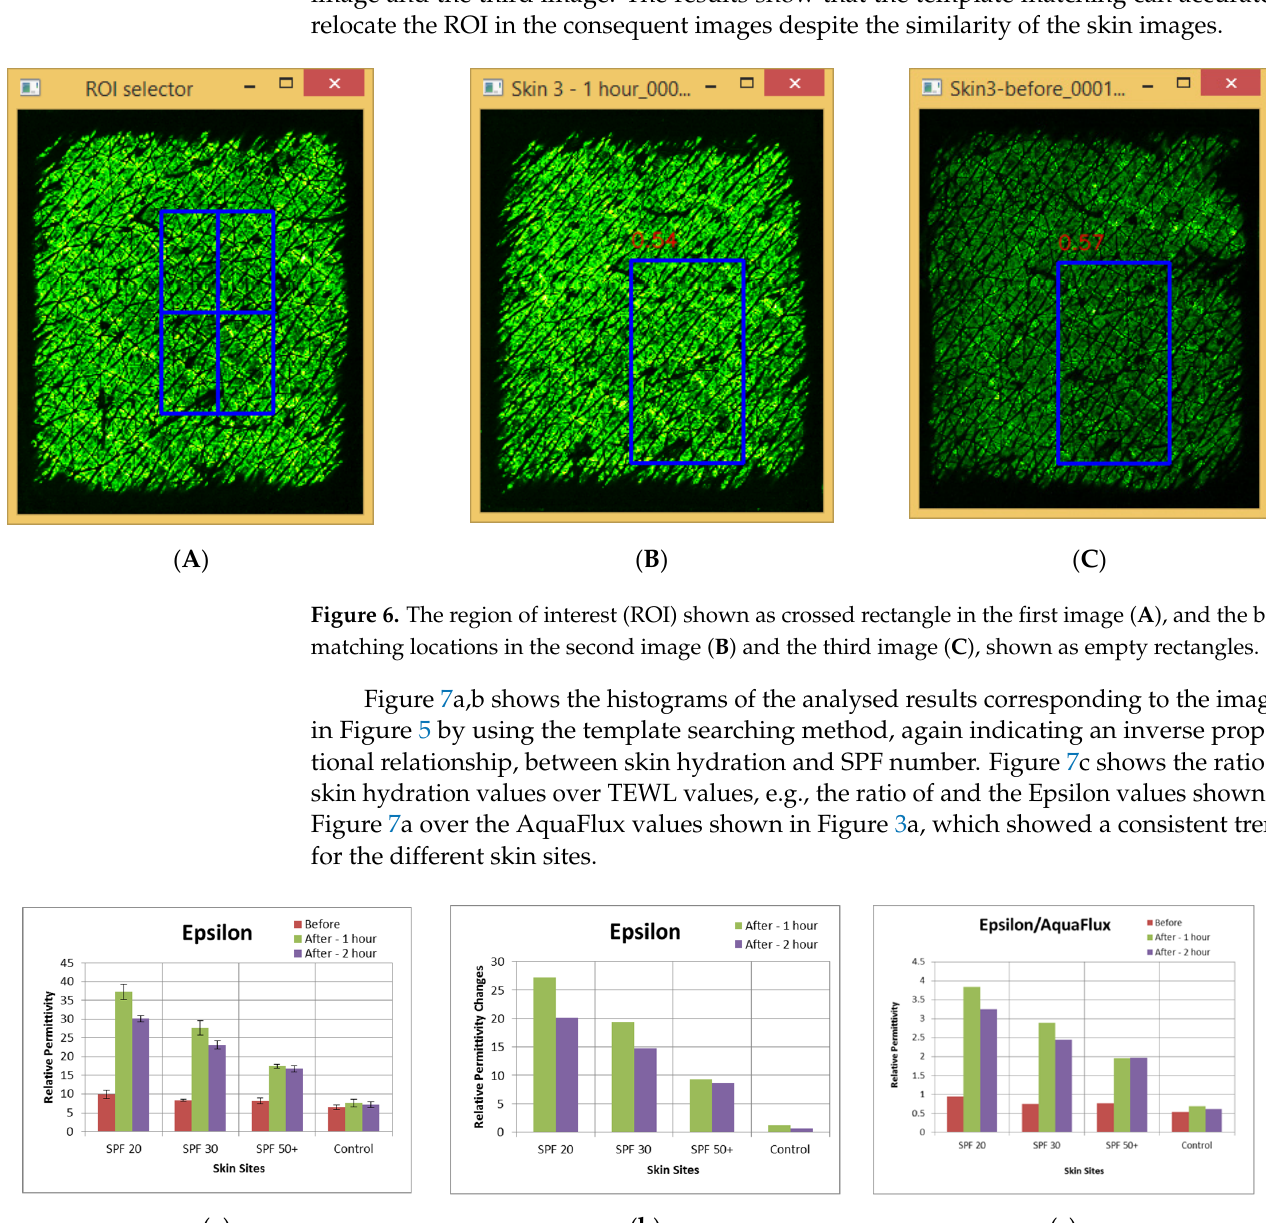
Figure 8. The Euclidean distances of skin control site after 2 h to different skin sites before and after the sun tan lotion application, where skin site 1: SPF 20, 2: SPF 30, 3: SPF 50+, and 4: control.